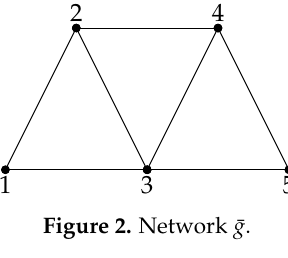
Figure 2. Network ¯ g